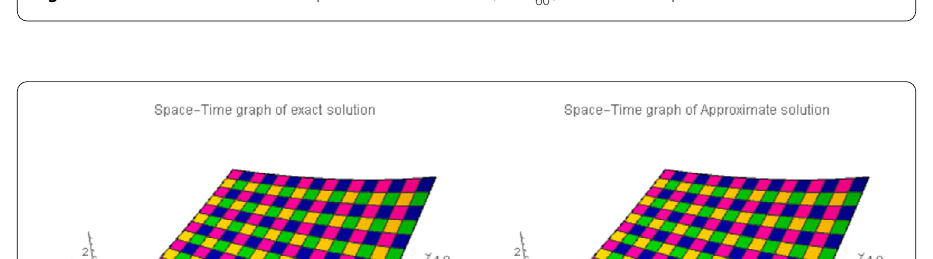
, h = 1 for Example 3 64 8